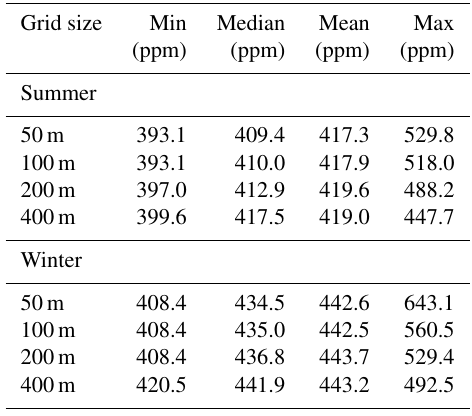
Table C1. Summary data of the measured mixing ratios for all grid sizes for the summer and winter campaigns. The table shows the mean, minimum, median, and maximum CO 2 mixing ratio r mobile for the gridded